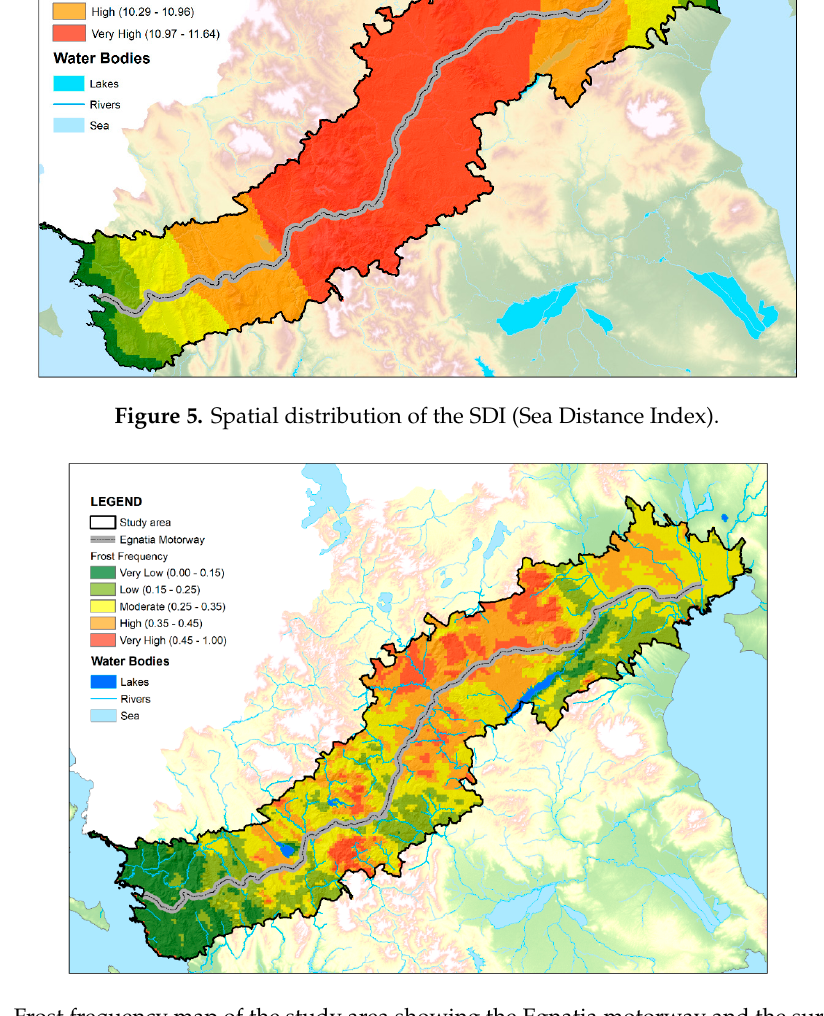
Table 2. Spearman’s statistical correlation analysis (r s ) among frost frequency, SDI, HDI and topography.